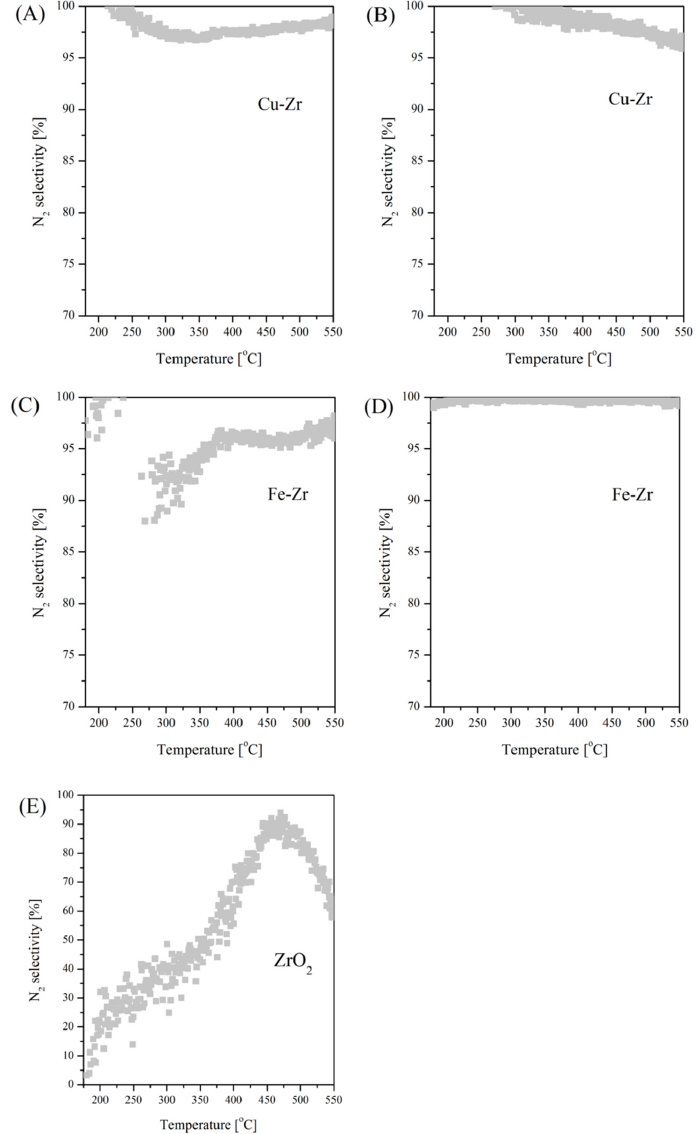
Figure 5. N 2 selectivity as a function of temperature measured during NH 3 -SCR over Cu-Zr catalyst ( A ) in absence of water, ( B ) in presence of water; Fe-Zr catalyst ( C ) in absence of water, ( D ) in presence of water; and ZrO 2 support ( E ) in absence of water. The experimental conditions: [NO] = 1000 ppm, [NH 3 ] = 1000 ppm, [H 2 O] = 3.5 vol% when used, [O 2 ] = 2.5 vol% diluted in helium; total flowrate of 100 mL/min.